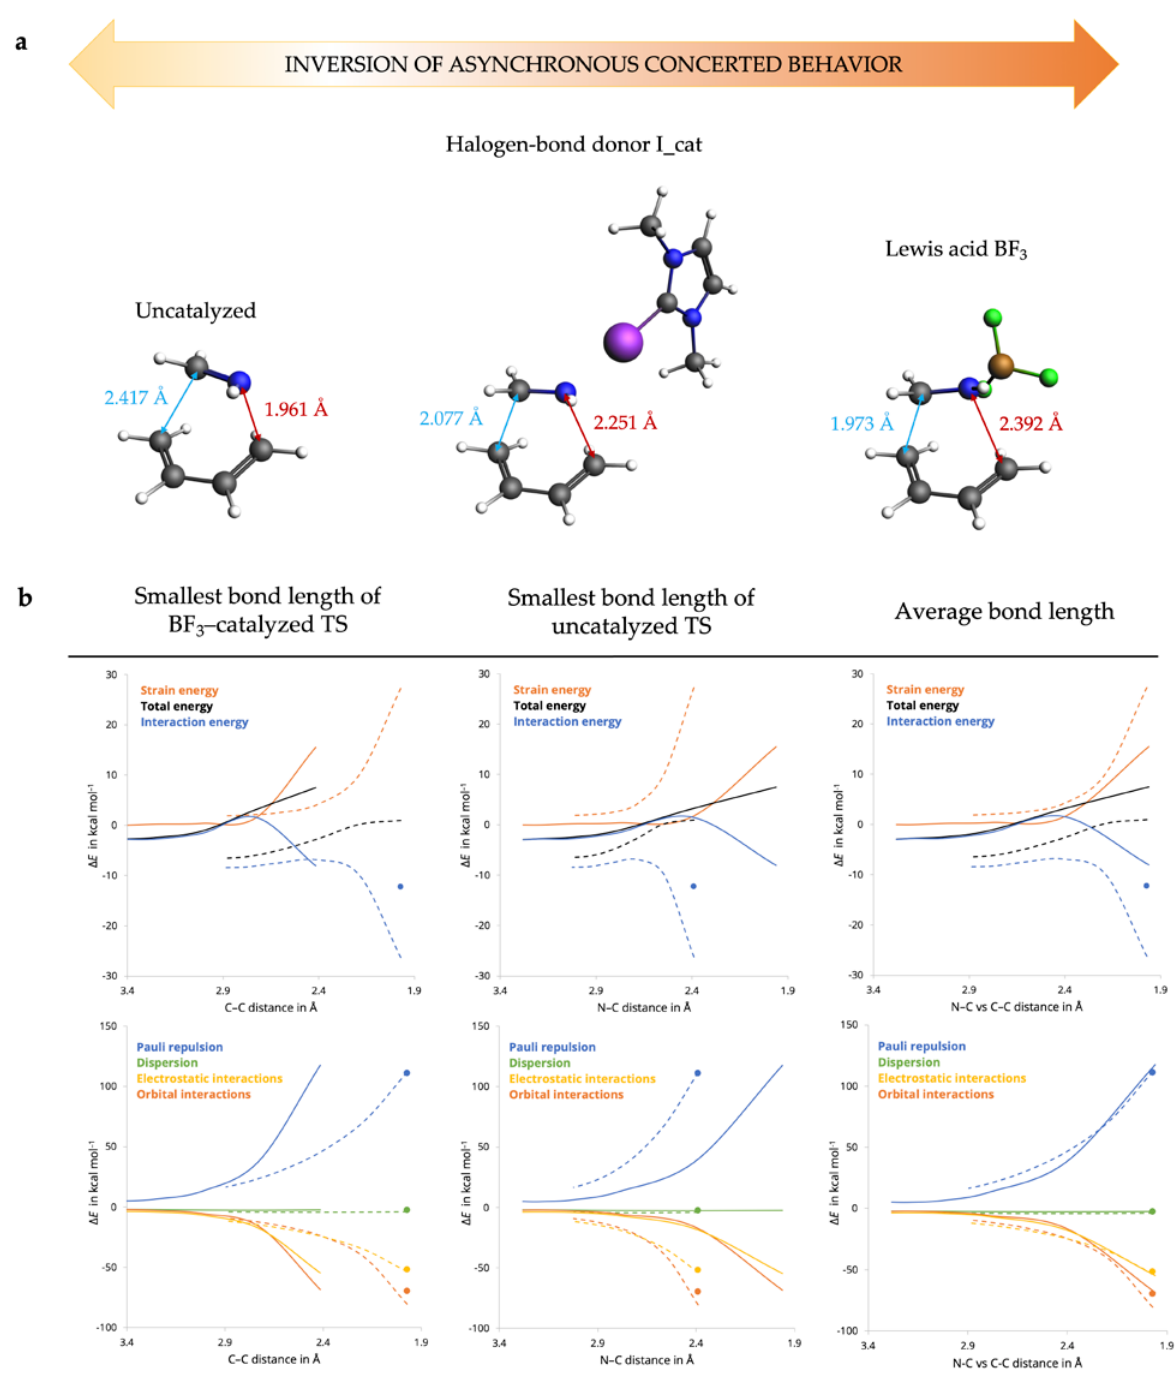
Figure 7. ( a ) Bond distances of the two bonds under formation in the transition-state geometries of the uncatalyzed, I_cat catalyzed, and BF 3 -catalyzed Diels–Alder reactions between methylene imine and 1,3-butadiene, and their connection to the asynchronous concerted behavior of the reactions. ( b ) ASM/EDA analyses of uncatalyzed and BF 3 -catalyzed reactions along the reaction coordinate projected onto the C–C bond length, the shortest bond being formed in the BF 3 -catalyzed TS geometry ( left ); the N–C bond length, the shortest bond being formed in the uncatalyzed TS geometry ( middle ); and the average bond distance ( right ).